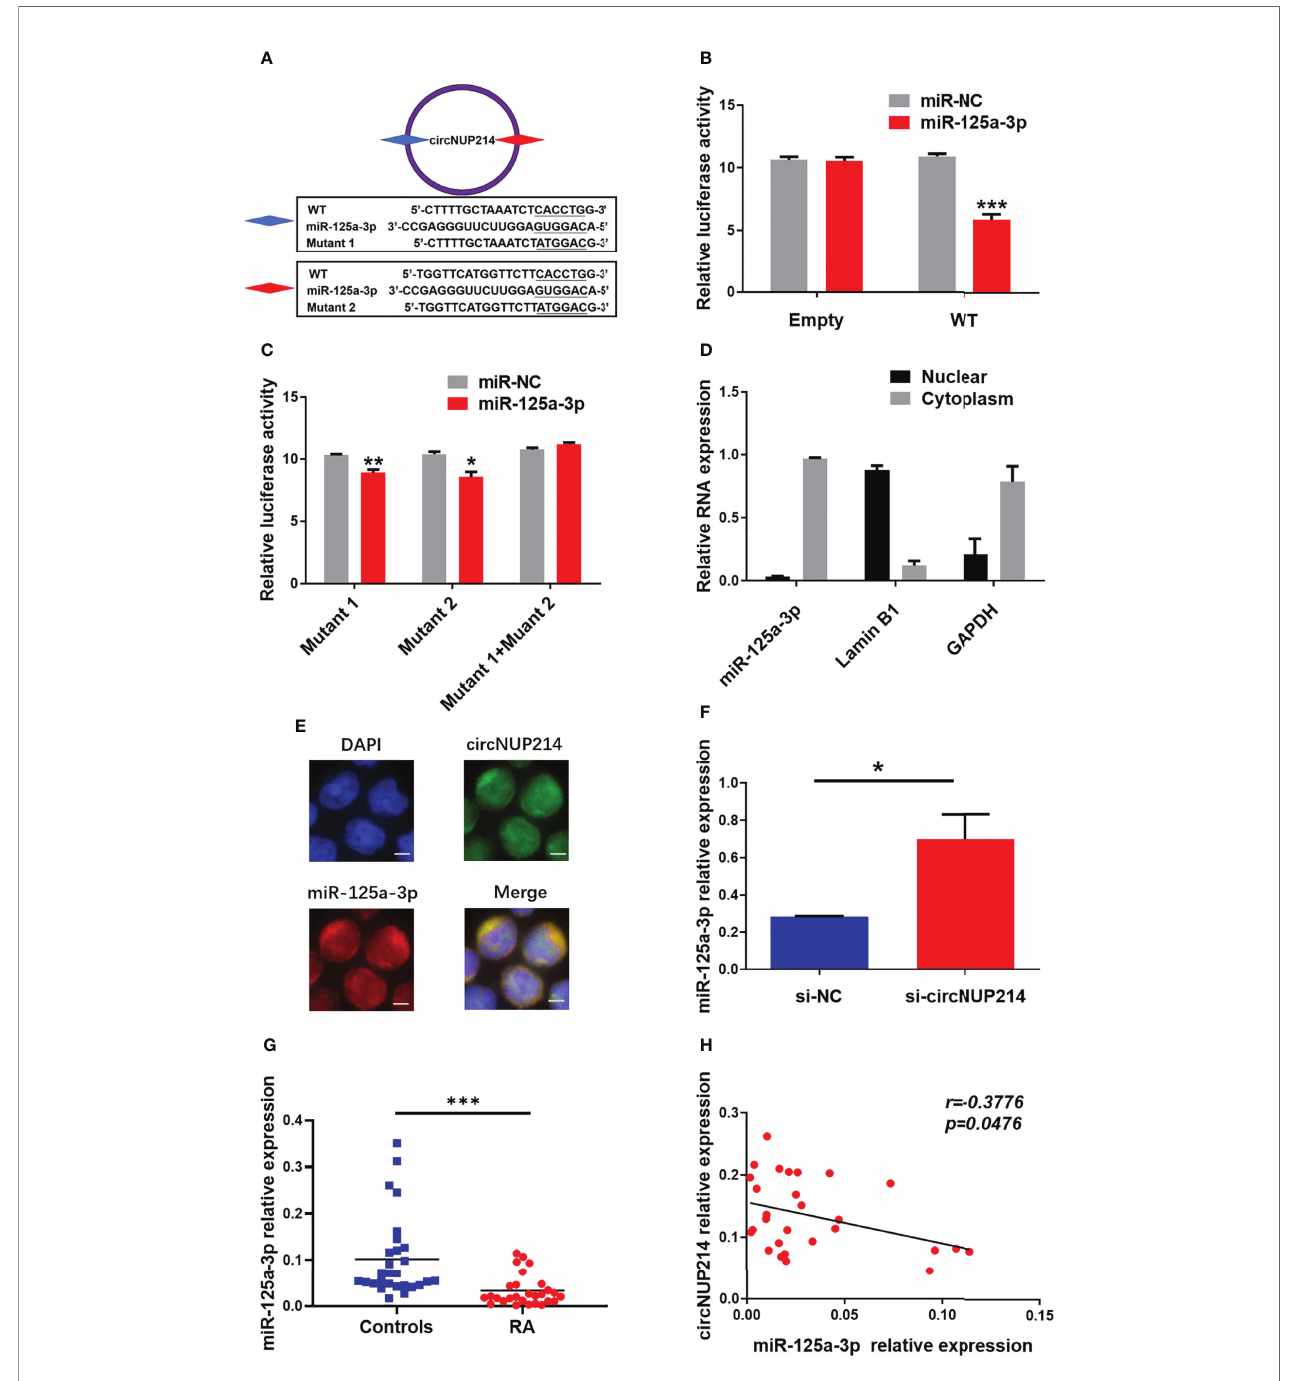
FIGURE 6 | CircNUP214 as a miR-125a-3p sponge in RA patients. (A) The binding sites of miR-125a-3p on the sequence of circNUP214 and the mutated sequences of circNUP214. (B) Luciferase activity of a reporter carrying WT and empty groups cotransfected into HEK293T cells with miR-125a-3p mimics and miR-NC. (C) Luciferase screening assay showed the luciferase activity of mutants 1, 2 and 1 + 2 transfected with miR-125a-3p mimics and miR-NC. Mutant 1 + Mutant 2 represents a mutant with both mutated sites. (D) The distribution of miR-125a-3p was determined by cytoplasmic and nuclear fractionation experiments. GAPDH and Lamin B1 were applied as positive controls in the cytoplasm and nucleus, respectively. (E) The colocalization of circNUP214 and miR-125a-3p in CD4 + T cells was shown by FISH. Scale bar, 25 µm. (F) The levels of miR-125a-3p in human CD4 + T cells transfected with si-circNUP214 and si-NC. Data represent mean ± S.D. from three independent experiments. (G) The relative expression of miR-125a-3p in PBMCs from 28 RA patients and 28 controls were determined by qRT – PCR. (H) The correlation between the levels of circNUP214 and the levels of miR-125a-3p in 28 RA patients. Each data point represents an individual subject, and the horizontal lines show the mean. * p < 0.05; ** p < 0.01; *** p <